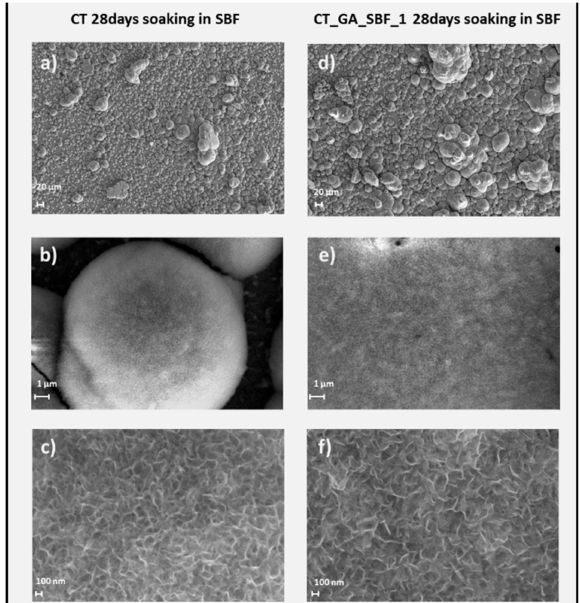
Figure 6. FESEM images of samples after 28 days SBF soaking at di ff erent magnifications. ( a ). (500 × ), ( b ) (20k × ) and ( c ) (100k × ) for CT sample, ( d ) (500 × ), ( e ) (20k × ) and (f) (100k × ) for CT_GA_SBF_1 one.